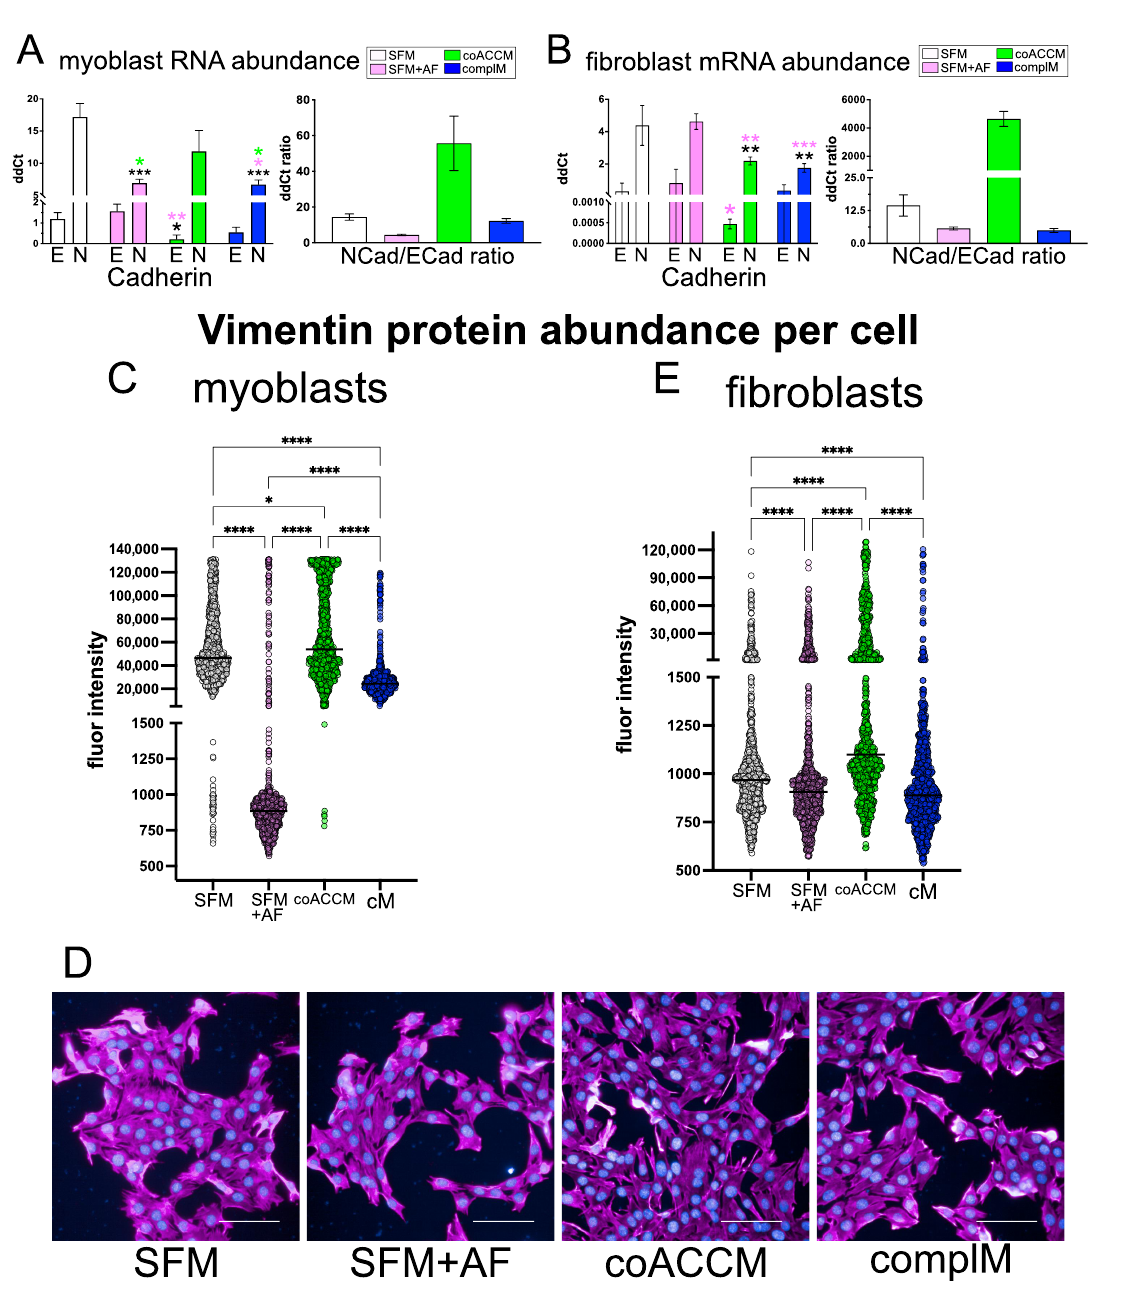
Figure 3. coACCM activates EMT biomarker expression, while AF represses their levels. ( A ) RT- qPCR measuring N-Cadherin , E-Cadherin or the ratio of N-cadherin to E-cadherin mRNA abundance from myoblast ( A ) or fibroblast ( B ) extracts following scratch test assay described above. The y-axis value indicates the mean ddCt calculated relative to Hmbs mRNA abundance ( n = 3 biological repli- cates; * p < 0.05, ** p < 0.01, *** p < 0.001 by one-way ANOVA and is color-coded (significant relative to SFM is black, relative to AF is pink, and relative to coACCM is green); no statistical significance was measured for the ratio of N-Cadherin to E-Cadherin mRNA since a relative ratio is statistically incalculable but shown to indicate a change in magnitude. ( C ) High content screening analysis of indirect immunofluorescence staining for Vimentin protein in myoblasts in which fluorescence intensity per cell ( n = 1000 per condition) was calculated for each media condition described above: SFM, SFM + AF, coACCM or complete media (cM); statistical significance was determined by Mann– Whitney U analysis; **** p < 0.0001. ( D ) Representative images from the analysis described in ( C ) above showing Vimentin (magenta) and DAPI (blue). Scale bar = 100 µ m. ( E ) High content screening analysis as in ( C ) but in fibroblasts (**** p < 0.0001 by Mann–Whitney